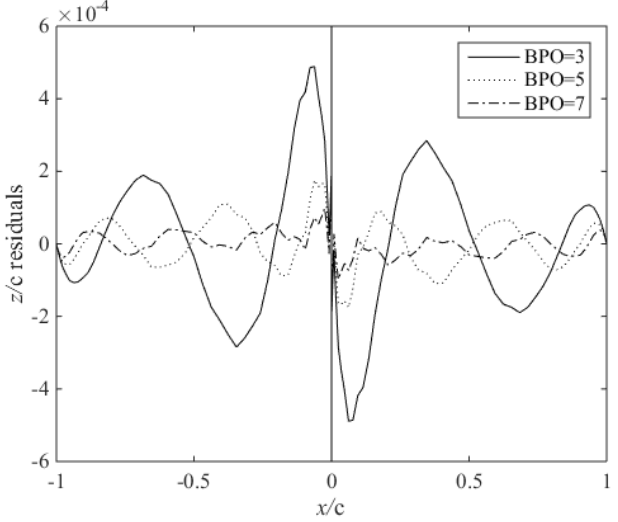
Figure 3. CST parameterization residuals of the NACA0012 airfoil.